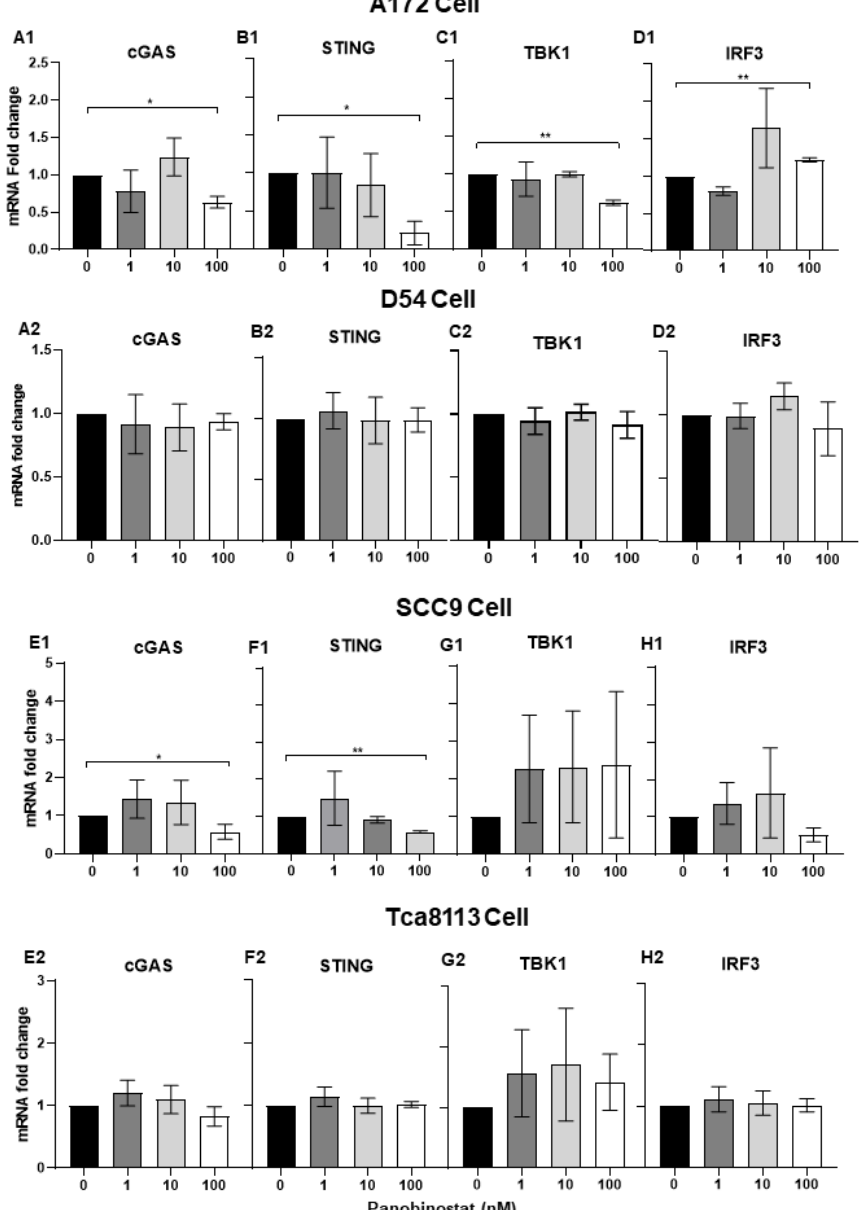
Figure 4. Suppression of the transcriptional expression of cGAS/STING in human glioma and squa- mous cell carcinoma cells when treated with panobinostat. A172 ( A1 , B1 , C1 , D1 ), D54 ( A2 , B2 , C2 , D2